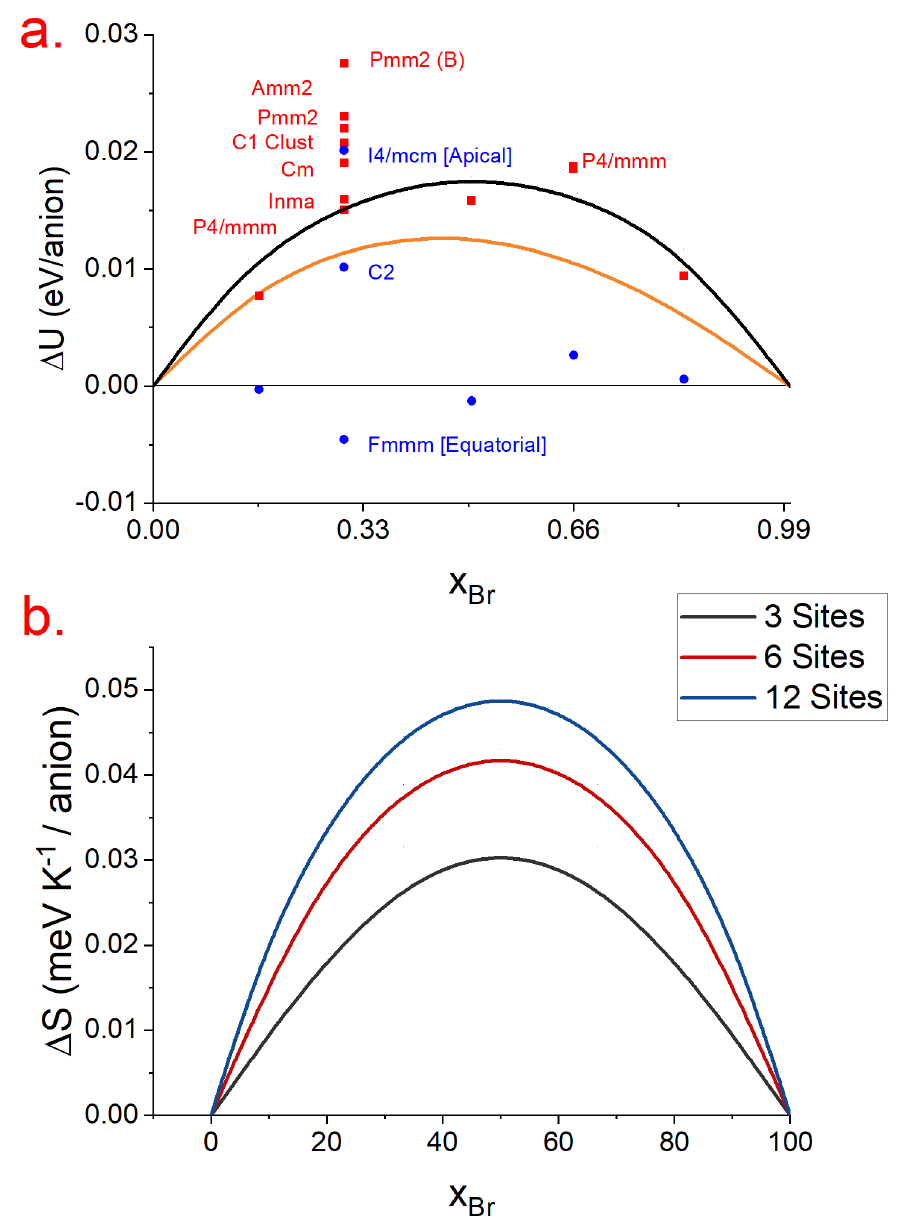
Figure 5. ( a ) The mixing energies ∆U of all the phases calculated. The room temperature solid solution approximation Ωx(1−x) Ω = 0.06 − 0.02x (orange line) and the approximation for a completely random alloy in the high temperature limit (black line) are also plotted; ( b ) The configurational entropy depending on the number of halide sites in the unit cell.